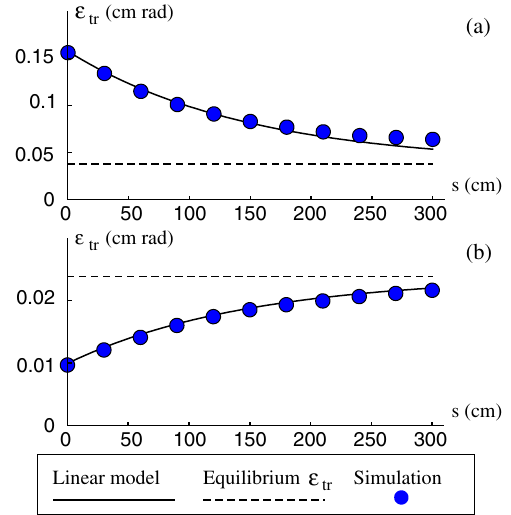
FIG. 3. Linear model of transverse motion compared to simu- lation in the cases of (a) large initial transverse emittance and (b) small